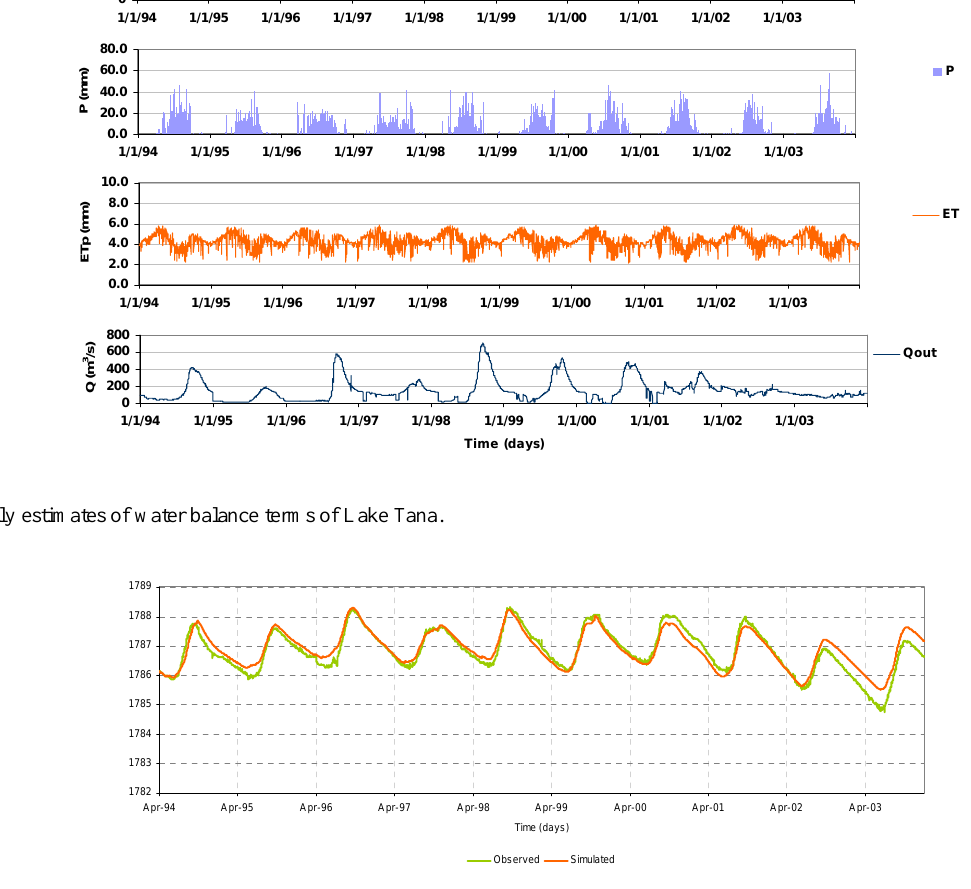
Figure 7: Comparison of simulated to observed lake levels